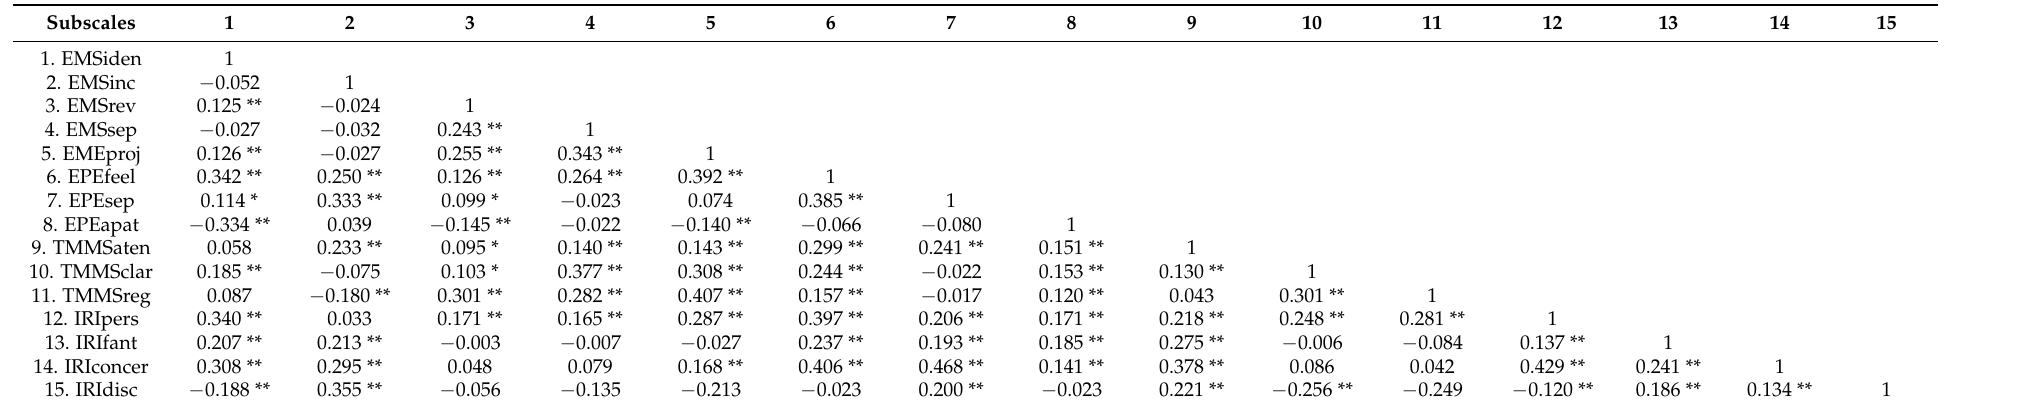
Table 3. Correlations among EMS, EPE, TMMS-24, and IRI